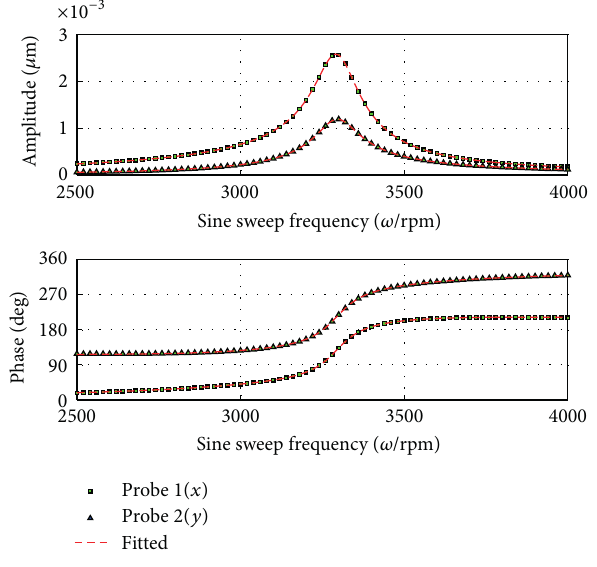
Figure 4: Fitted result based on RFP method.